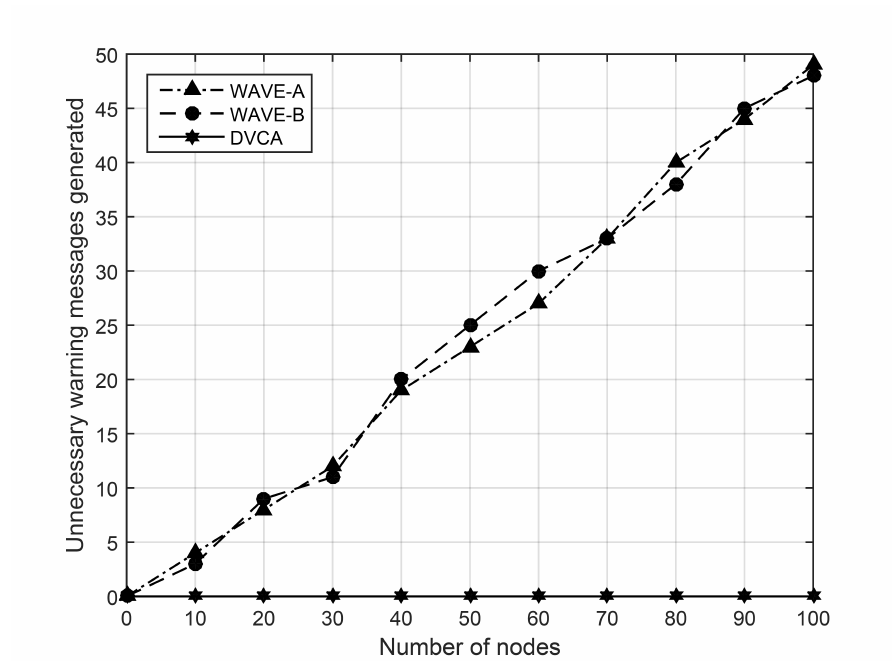
Figure 10. Unnecessary warning messages